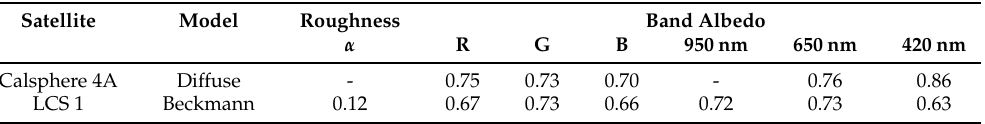
Table 2. Fitted simulation parameters based on observed passes in the RGB camera and Single Photon Avalanche Diodes